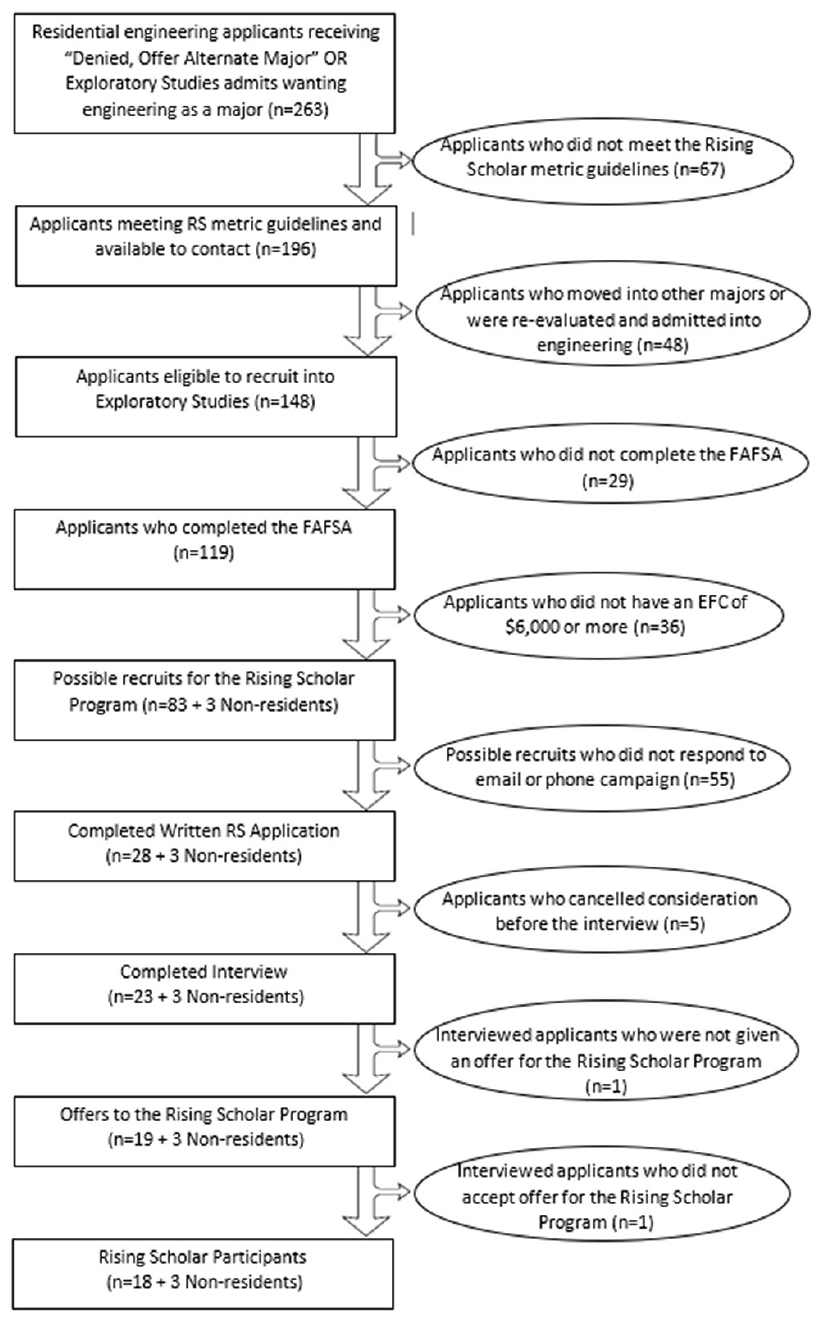
Fig. 6. Fall 2017–2019 recruitment process pathway details for the Purdue Rising